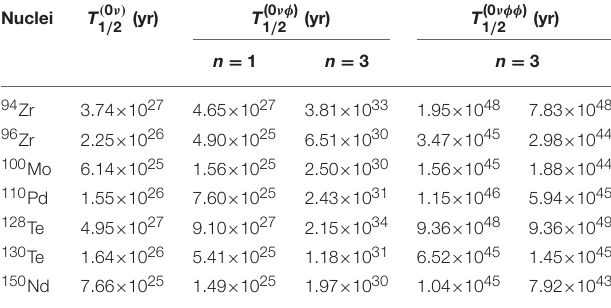
TABLE 11 | Predicted half-lives T ( 0 ν) 1 / 2 ( yr ), T (0 νφ ) 1 / 2 ( yr ) and T (0 νφφ ) 1 / 2 ( yr ) of 94 Zr, 96